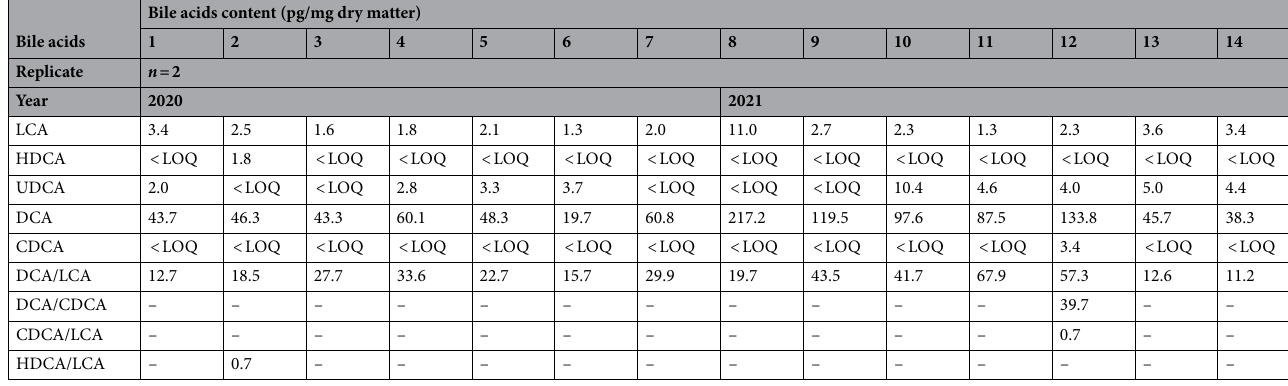
Table 5. BA contents and ratios of analysed soil sediments.